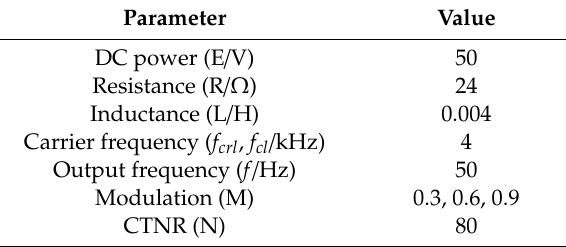
Table 2. Key parameters of the Simulink model .